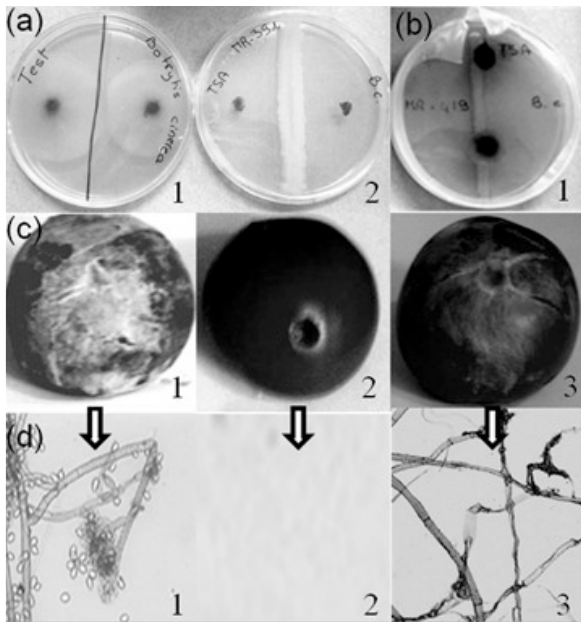
Figure 2. Screening in vitro and in vivo of bacterial antago- nists against Botrytis cinerea. (a and b) test in vitro : (a1) control, (a2) antagonism due to diffusible compounds of Bacillus safensis B582 and (b1) antagonism due to volatile compounds of Bacillus oceanisediminis B584. (c) Test in vivo : (c1) control, (c2) Total inhibition by Bacillus safensis B582 and (c3) Partial inhibition by Vibrio sp. B663. (d) Microscop- ic observation (Magnification: 10 × 100 Observation): (d1) Normal mycelia of B. cinerea , (d2) No visible mycelia Bacil- lus safensis B582. (d3) Abnormal mycelia of B. cinerea inhib- ited by the antagonistic bacterial isolate Vibrio sp .